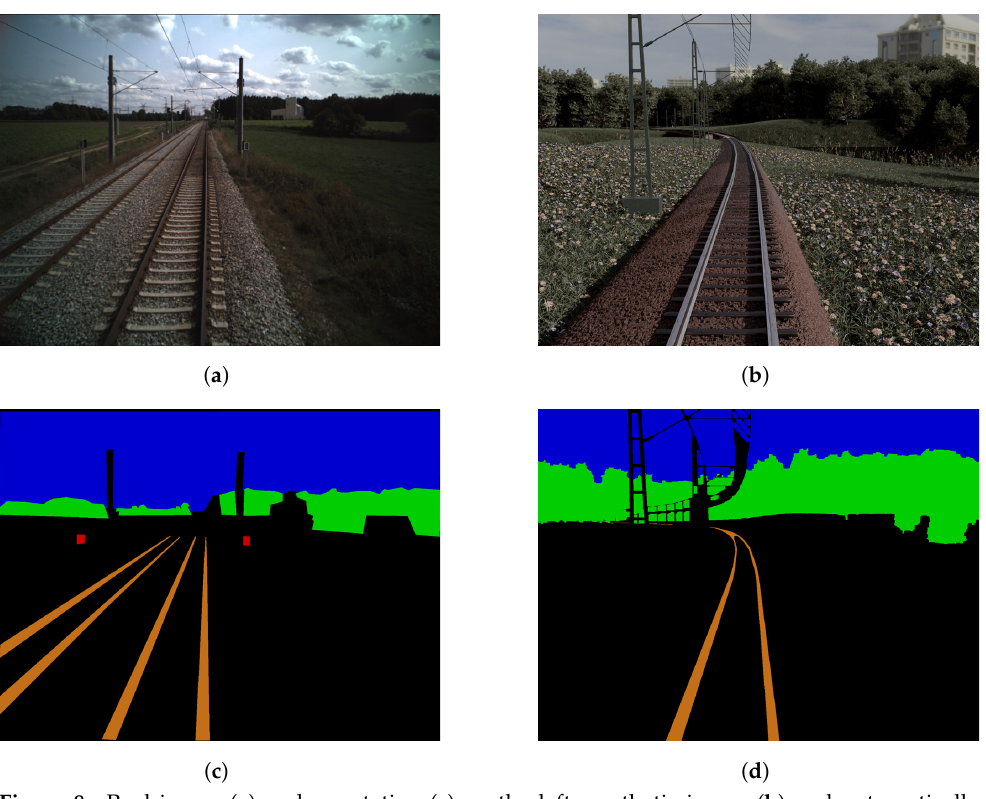
Figure 8. Real image ( a ) and annotation ( c ) on the left, synthetic image ( b ) and automatically generated annotation ( d ) on the right.